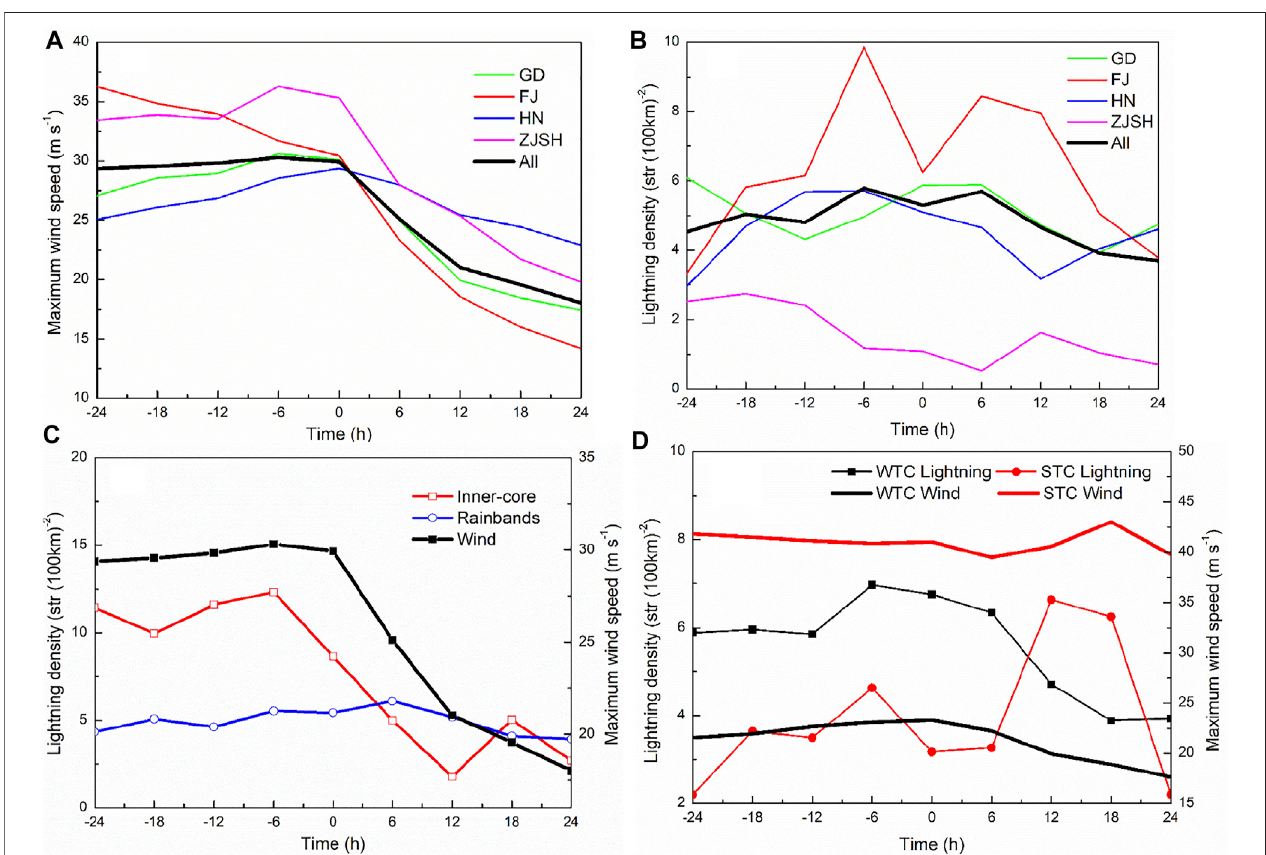
FIGURE 7 | Evolution of the mean maximum wind speed and lightning density (str (100 km) − 2 ) as a function of (A,B) landing locations, (C) TC regions, and (D) TC intensities at 6-h intervals from 24 h prior to and 24 h after landfall.